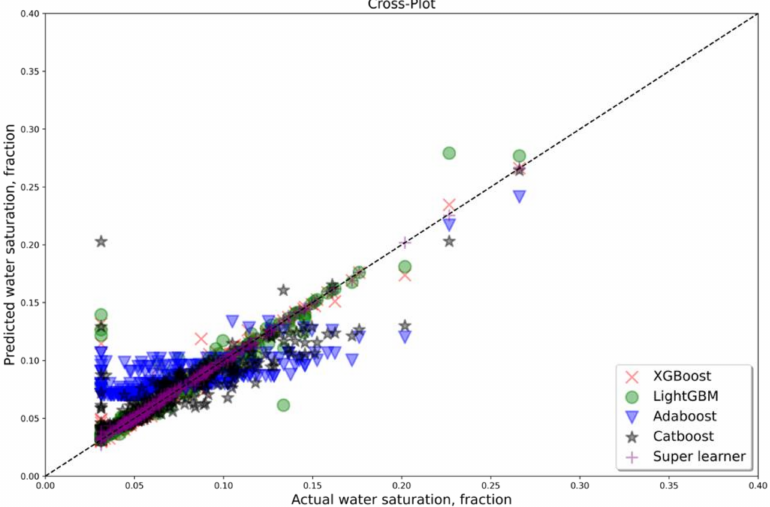
Figure A6. Cross plot for water saturation prediction results by different algorithms (Well